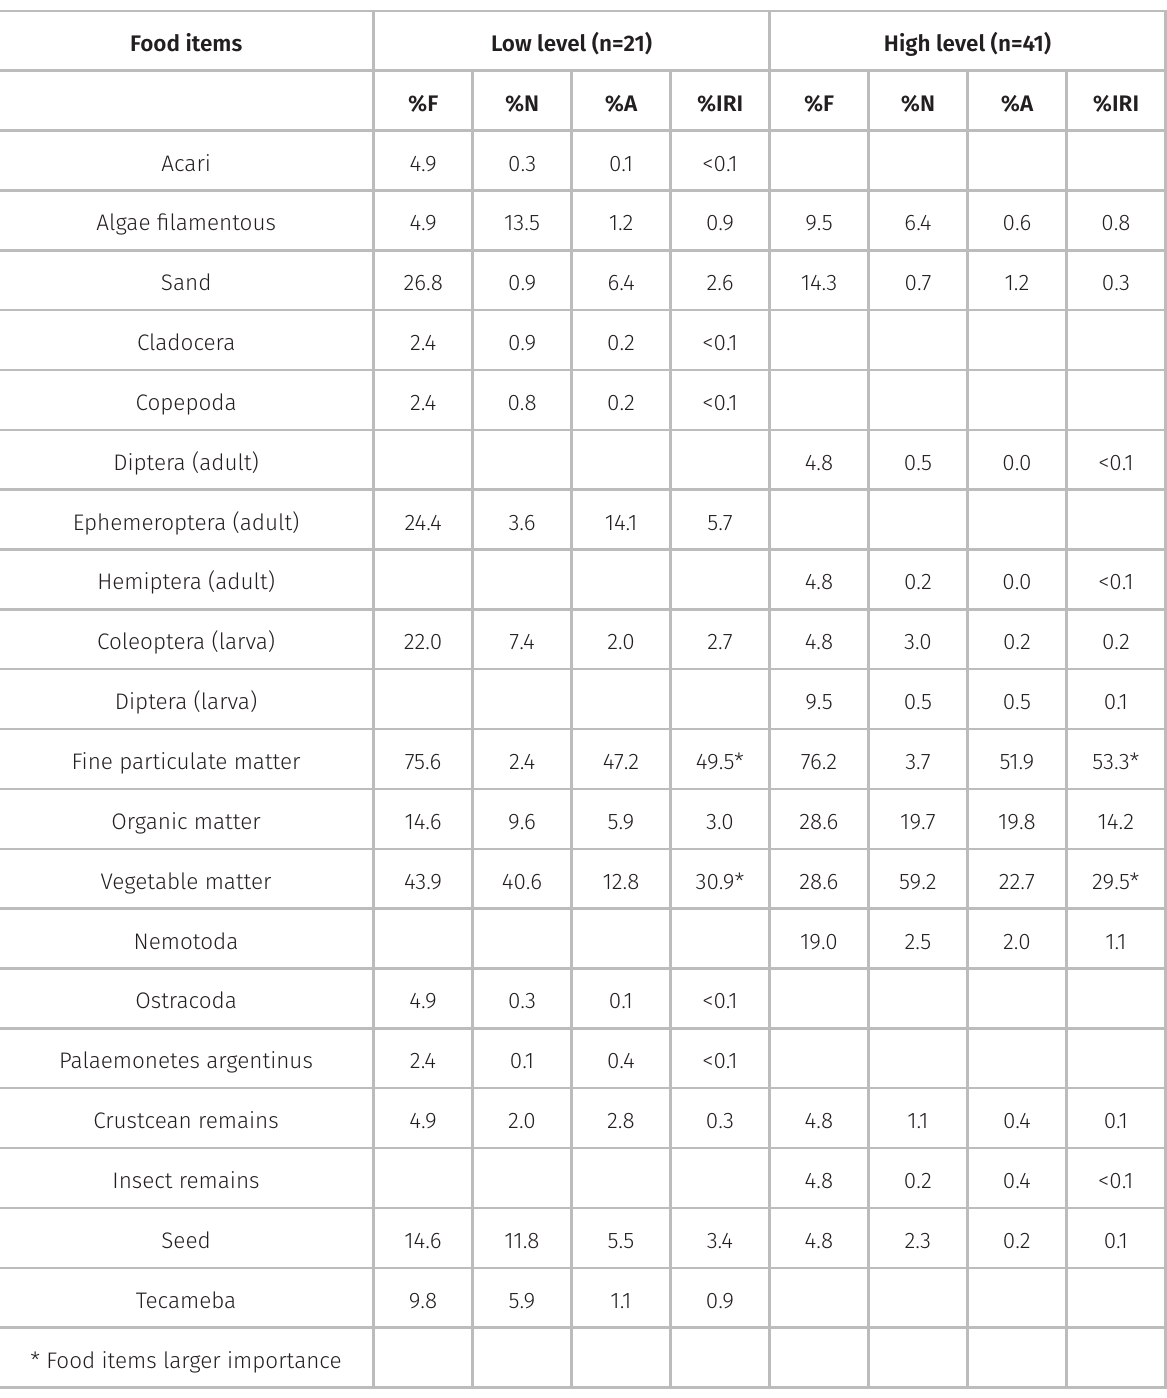
Table I. Frequency of occurrence (%F), numeric frequency (%N), area (%A) and index of relative importance (%IRI) for food items consumed by L. anus collected during the low and high hydrological level in the Chasqueiro reservoir, southern